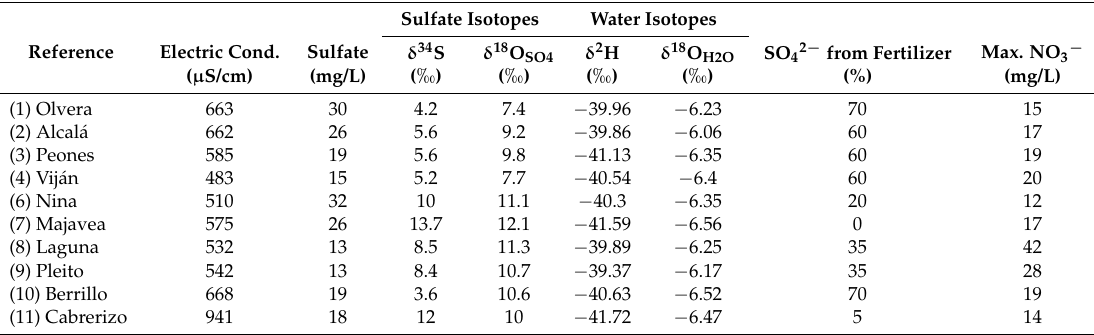
Table 5. Values of electrical conductivity, sulfate concentration, the deviation of isotopes of sulfate and water and the percentage of sulfate from fertilizers. Sulfate Isotopes Water Isotopes Reference Electric